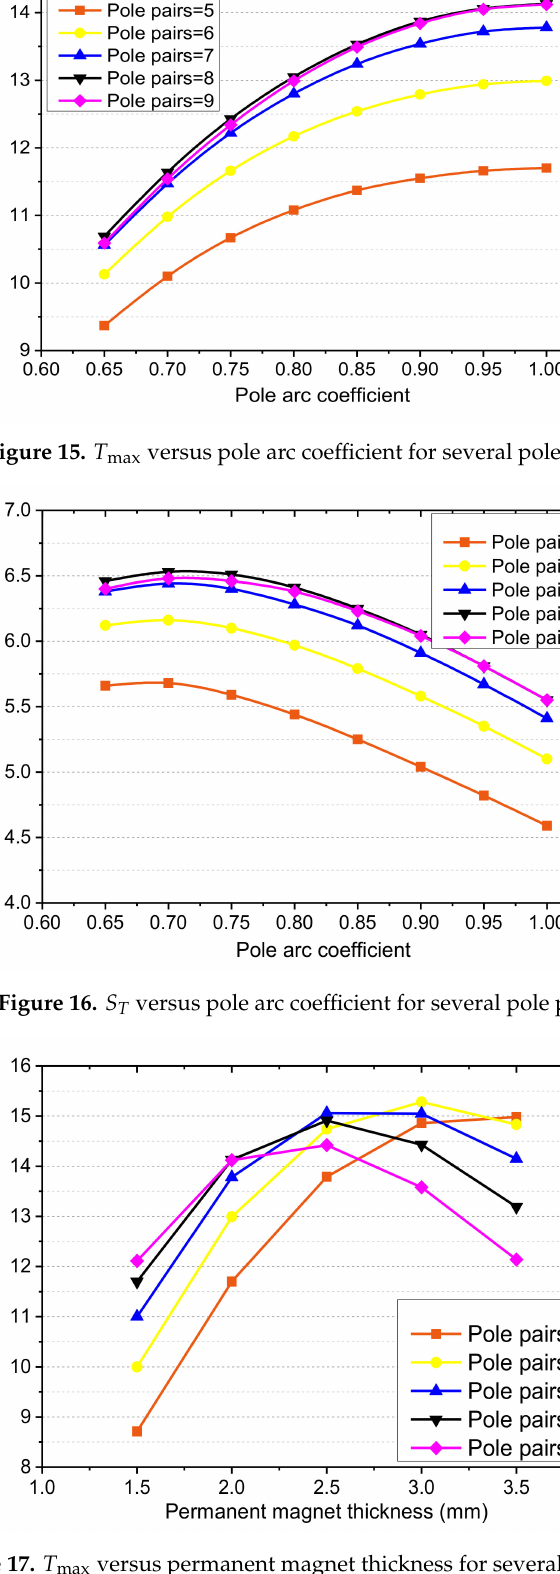
Figure 17. T max versus permanent magnet thickness for several pole